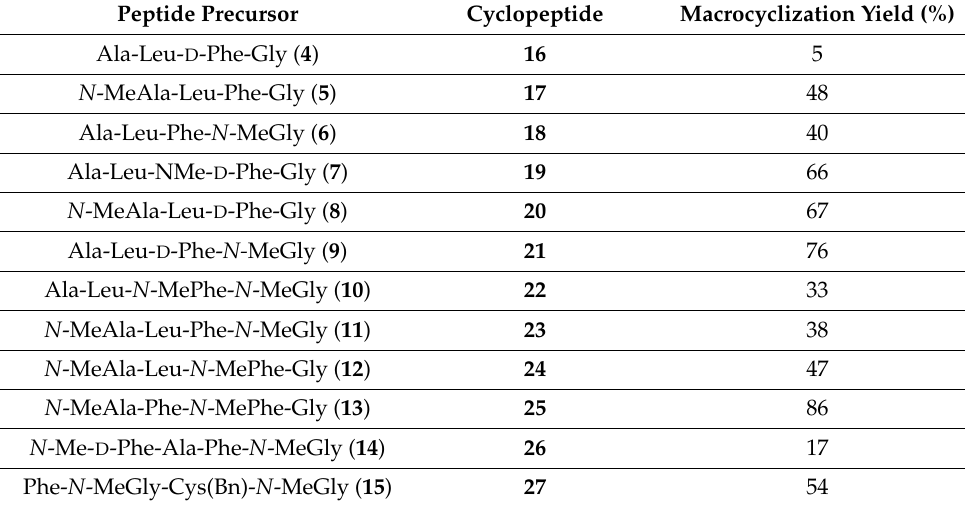
Table 2. Peptide precursors, cyclotetrapeptides and macrocyclization yield. Peptide Precursor